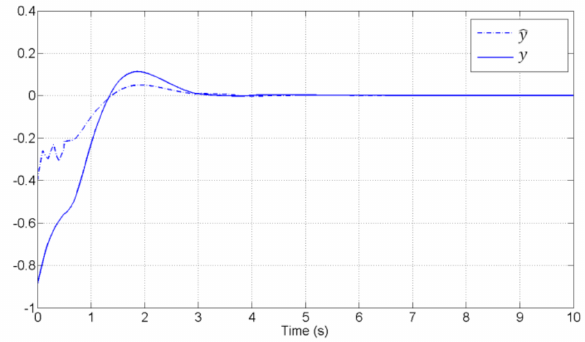
Figure 6. Observer output ( ˆ y ) and measured output ( y ).